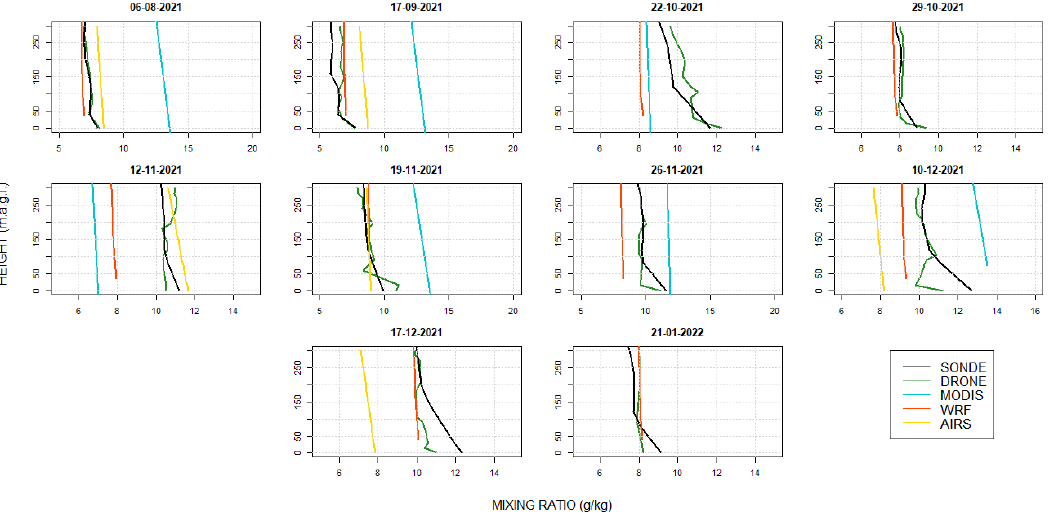
Figure A1. Mixing ratio profiles measured with radiosonde (black), drone (green), MODIS (sky-blue), AIRS (yellow), and WRF (orange) up to 300 magl. for 10 measurement events.